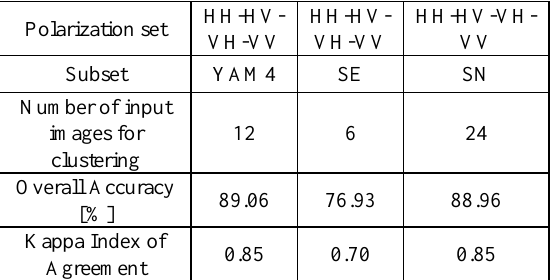
Table 4. The results of Accuracy Assessment for subsets A,B,C extracted from Experimental Quad-Pol data for 5 thematic